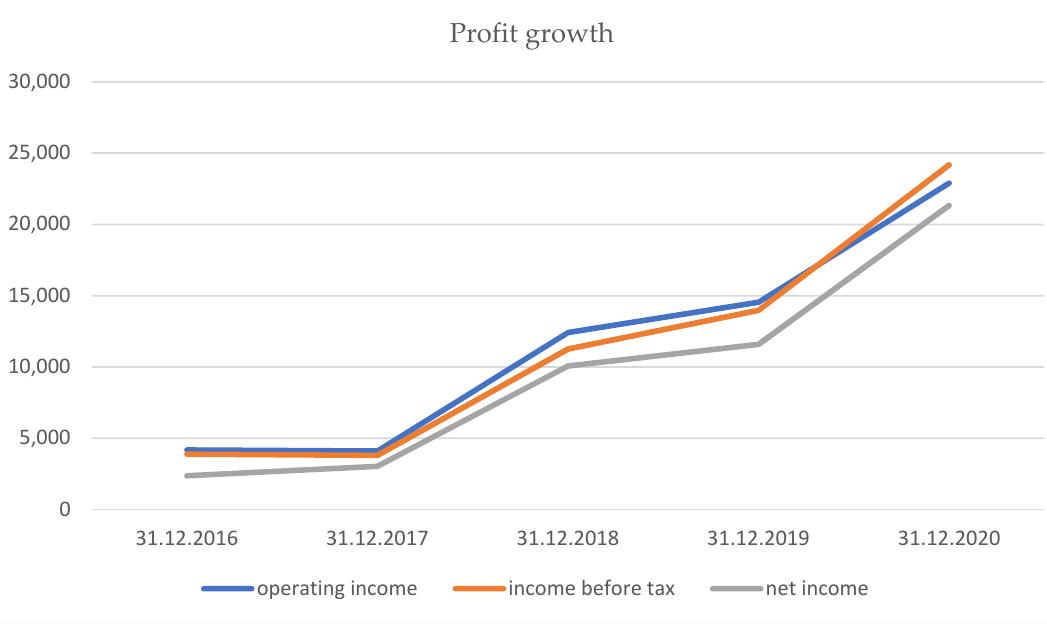
Figure 2. Amazon’s profit growth chart.